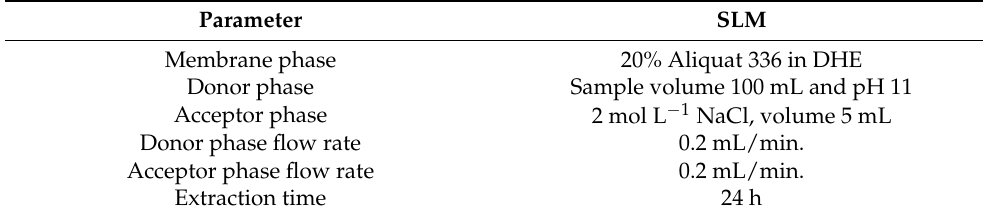
Table 2. The selected parameters of SLM extraction of the tested analytes.